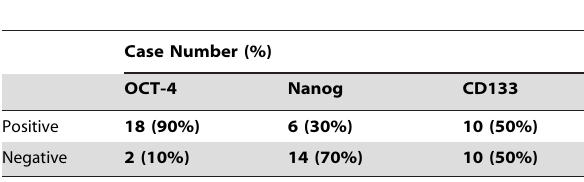
Table 1. Comparative analysis of the results of immunoexpression of three CSC-representative markers showing variable positive and negative numbers, and proportions in 20 patients with MPE.